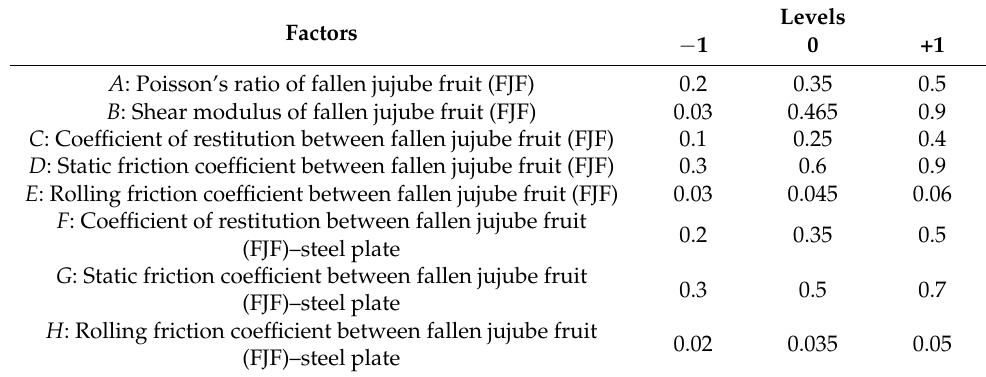
Table 2. The factors and levels of the simulation parameters for the Plackett–Burman